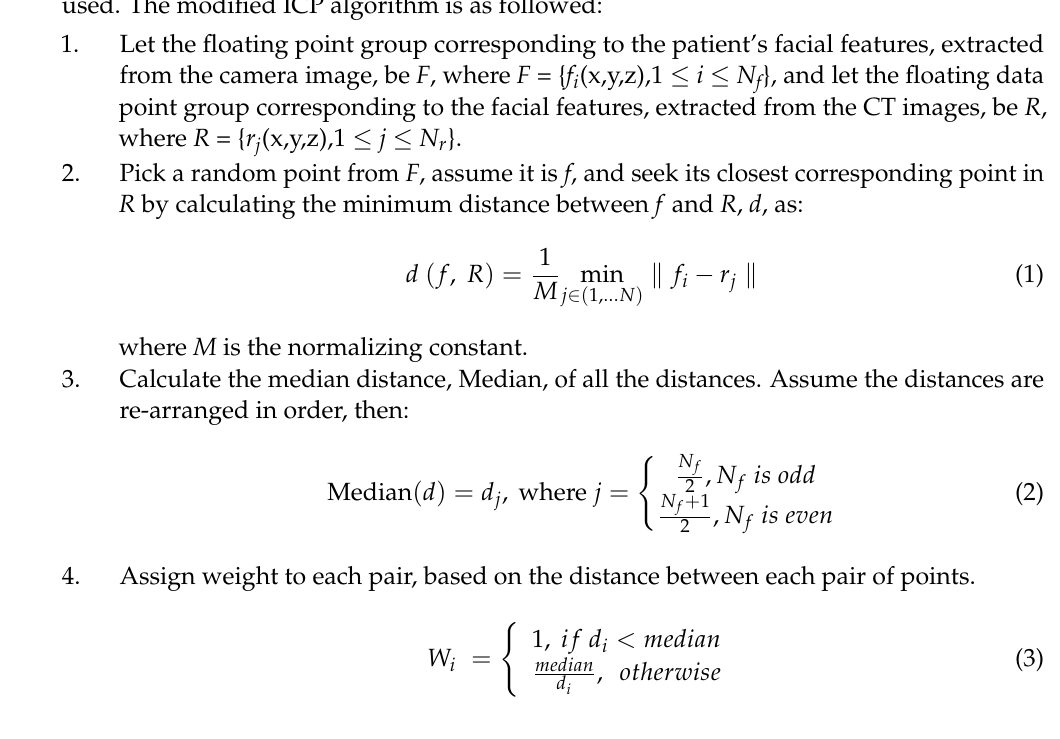
Figure 3. Example of a 3D model of cranial blood vessels.